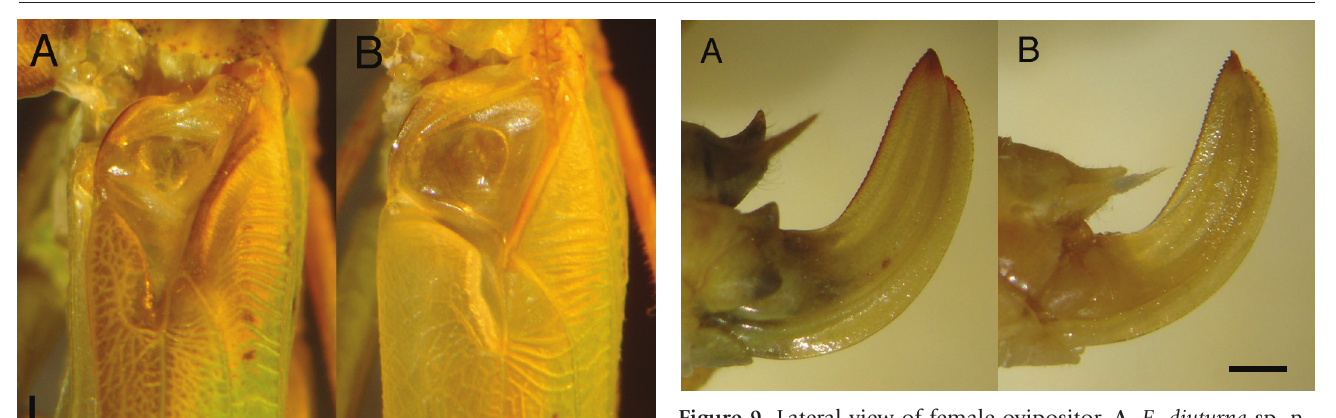
Figure 9. Lateral view of female ovipositor. A. E. diuturna sp. n., B. E. fulva . Scale 1